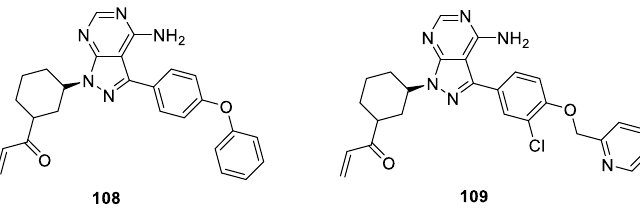
Figure 20. Chemical structures of 1 H -indazole derivatives 108 and 109 .